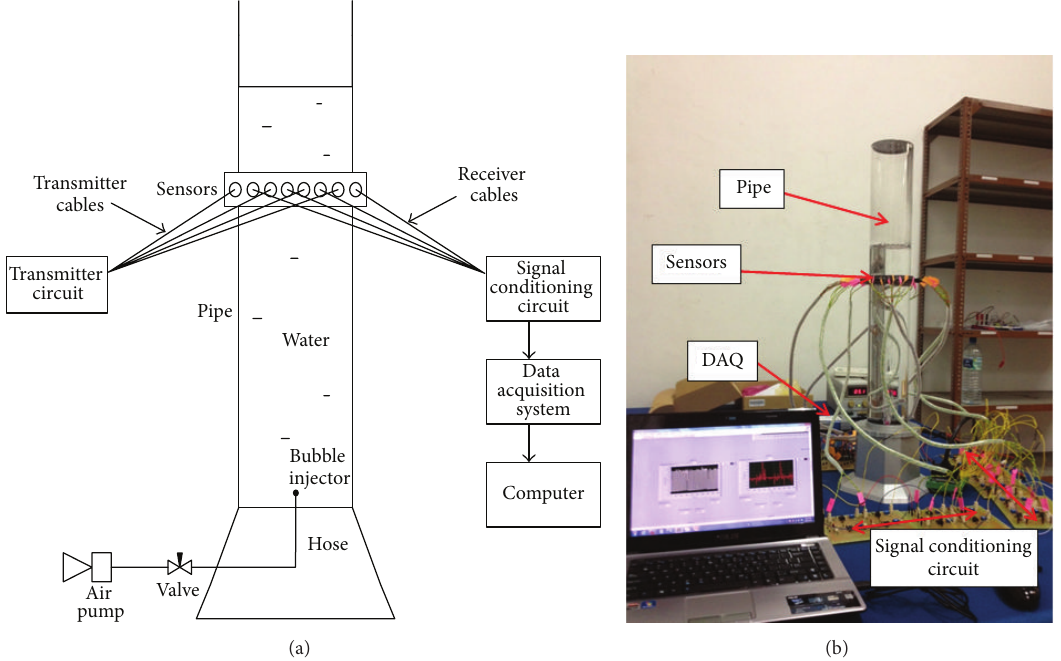
Figure 7: (a) The overall design of the optical tomography system. (b) The preparation of the